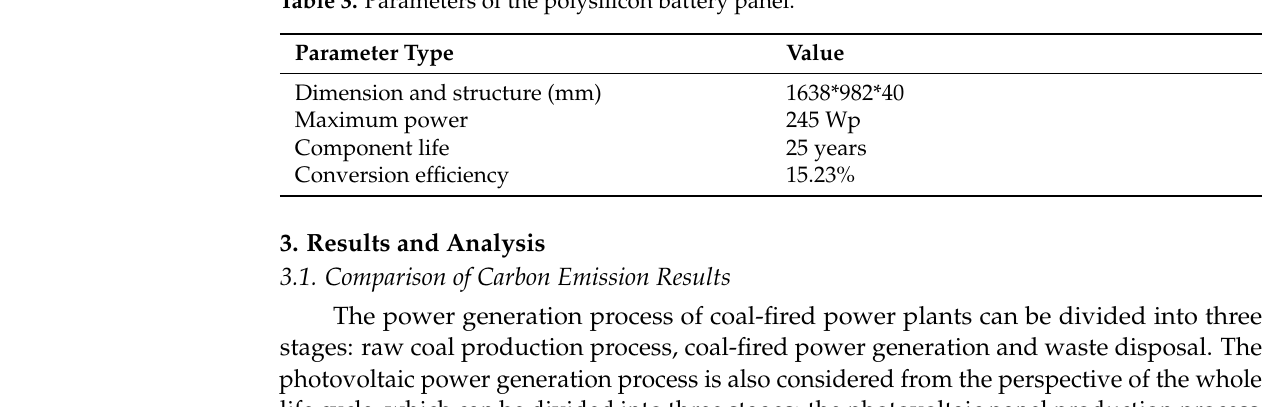
Table 3. Parameters of the polysilicon battery